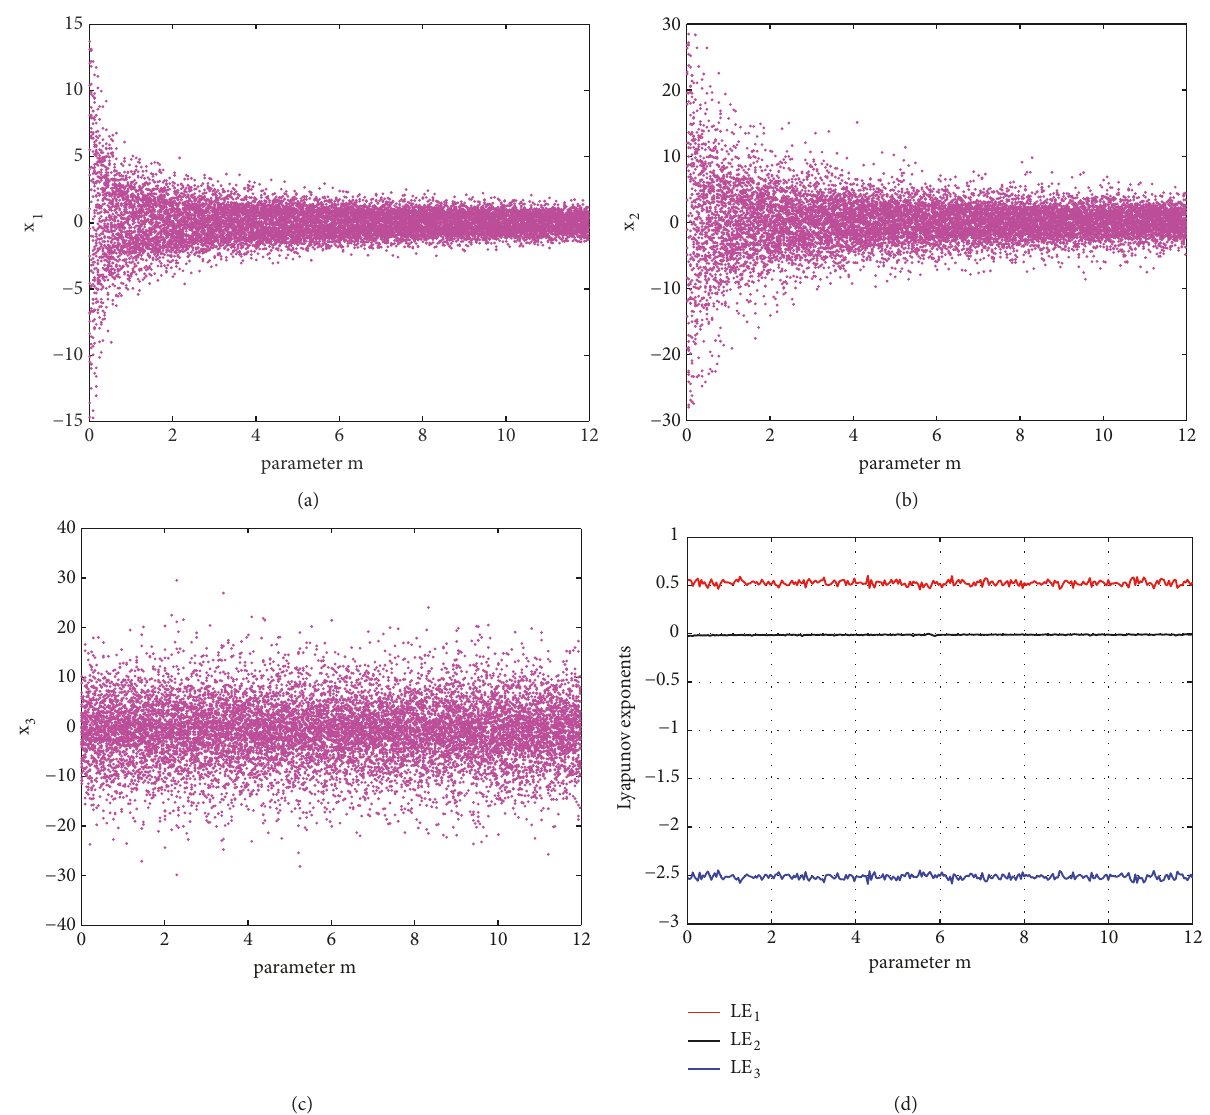
Figure 2: (a), (b), and (c) Bifurcation diagram and (d) Lyapunov exponent spectrum versus parameter m